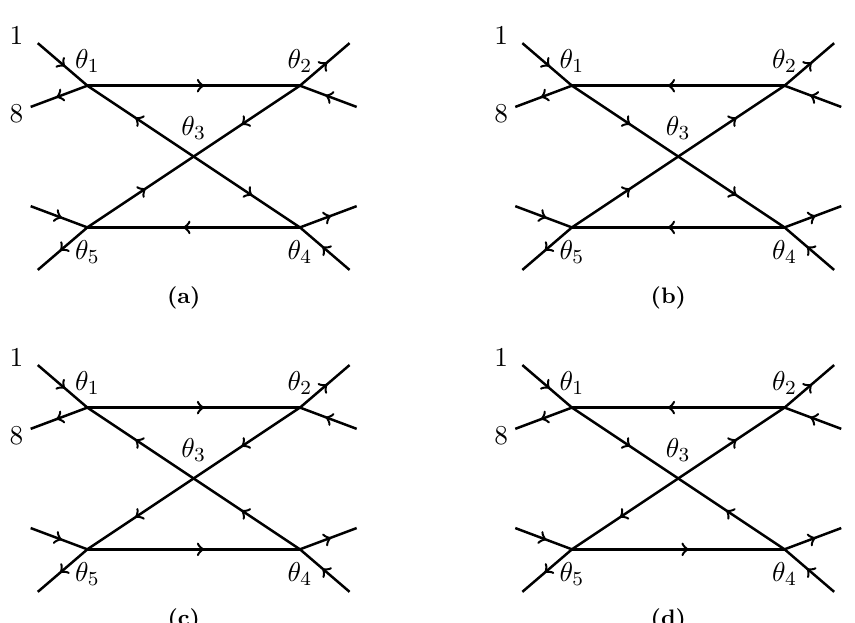
Figure 3. There are eight BCFW diagrams that contribute to the eight-point tree-level amplitudes. Here we have only listed four diagrams corresponding to different ways of arranging arrow flow of the internal lines, the other set of four diagrams can be obtained by a simple cyclic shift on the external